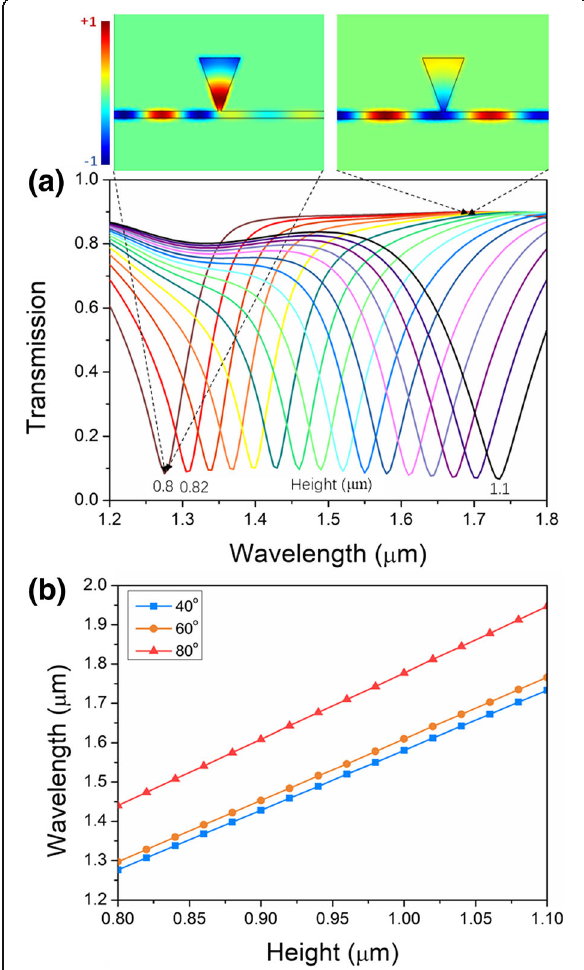
Fig. 3 Transmission properties of the single triangular resonator . a Transmission spectra of the single triangular resonator for varying height. b Dependence of resonant wavelength on height for angles of 40°, 60°, and 80°. Insets are magnetic field H z corresponding to the resonant and non-resonant wavelengths